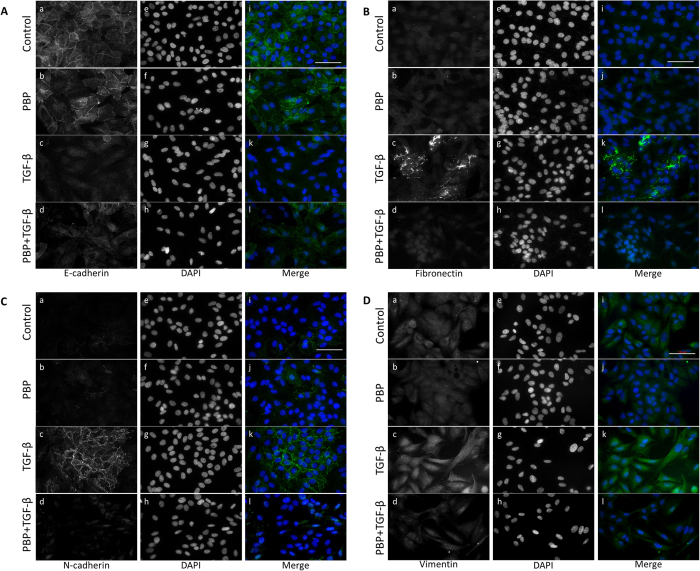
PBP attenuated TGF-β-induced EMT in A549 cells.EMT was determined by immunostaining for epithelial marker E-cadherin (A), ECM protein fibronectin (B), and mesenchymal markers N-cadherin and vimentin (C and D, respectively). A549 cells cultured on a cover glass were treated with TGF-β (100 pM) in 0.1% FCS in the presence or absence of PBP (5 μM) for 48 h. Cells were fixed with 4% paraformaldehyde and then incubated with primary antibodies against E-cadherin, fibronectin, N-cadherin, and vimentin. Fluorescence signals were visualised using Alexa Fluor 488-conjugated secondary antibodies. Nuclei of the cells were stained with DAPI. Scale bar = 200 μm.